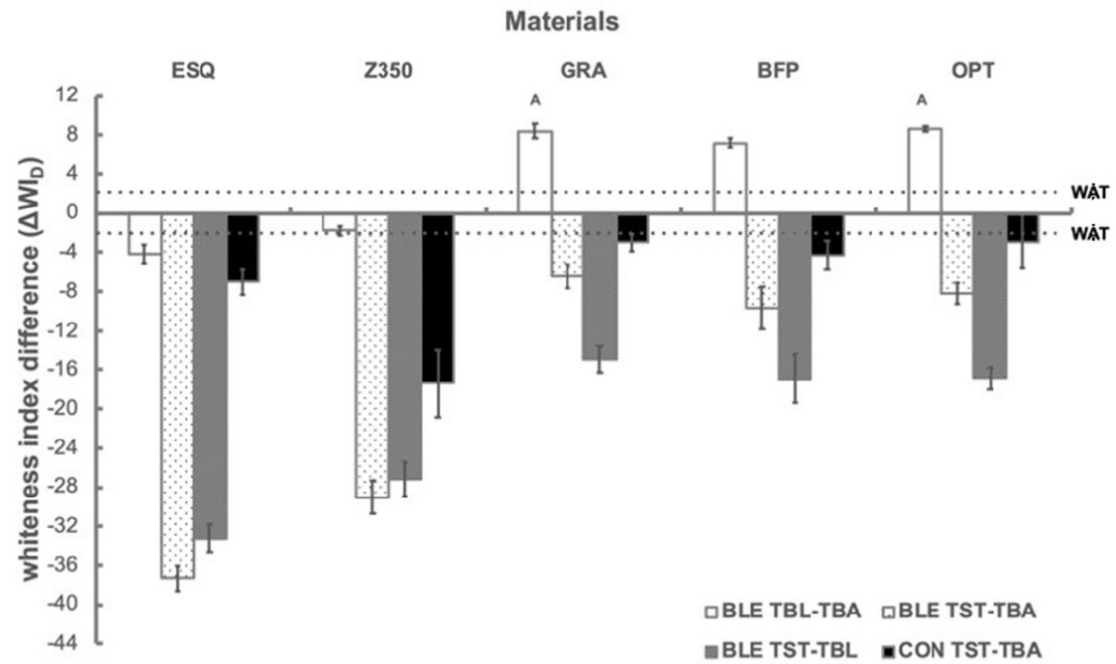
Figure 4. Mean and standard deviation values of variations in white index ( ∆ WI D ) between 2 different measuring time points (T BL -T BA , T ST -T BA , and T ST -T BL ) for each material from the BLA and CON groups. Dashed line at 2.9 represents the acceptability threshold (WAT) [16]. Same capital letter indicates no static difference between materials.